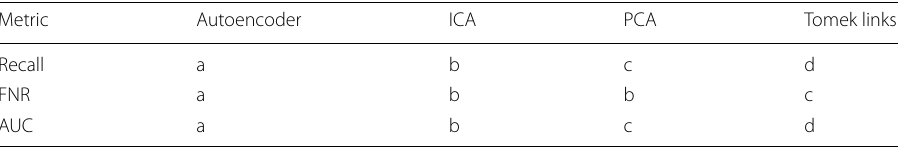
Table 6 Tukey’s HSD